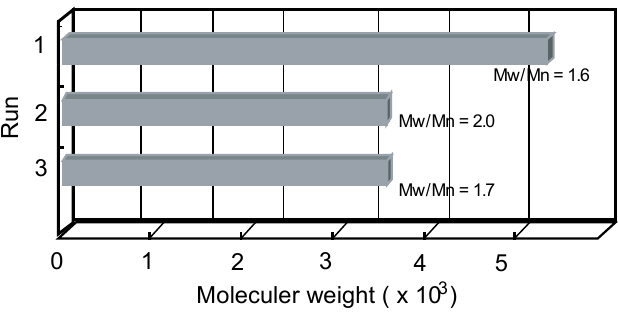
Figure 1. The molecular weight of PPO achieved from each run with recycling the recovered PSt- polyTACN copper complex as a catalyst in the oxidative polymerization of DMP.